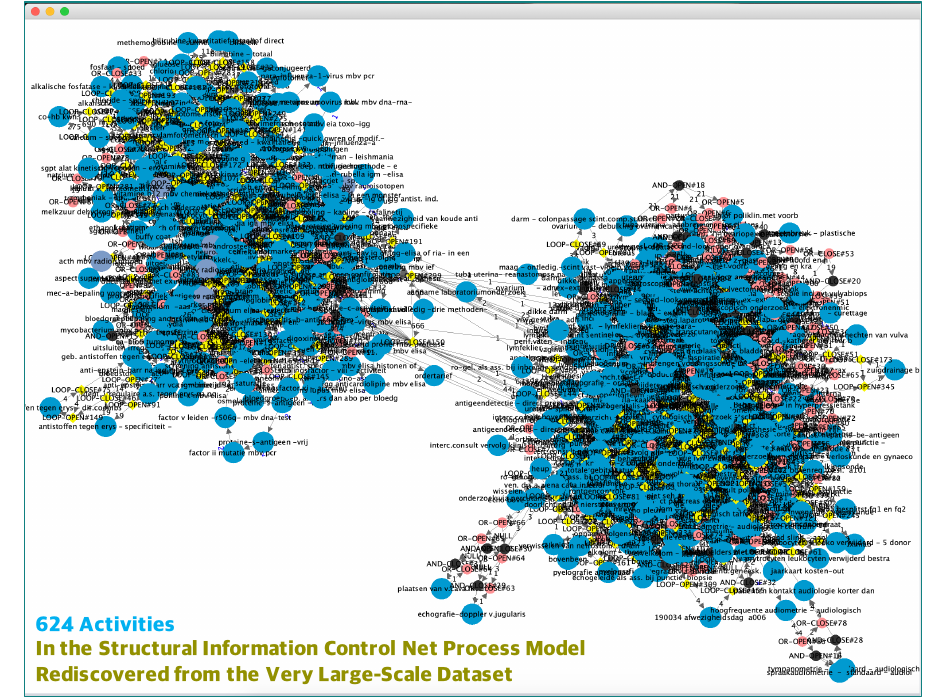
Figure 15. The rediscovered SICN process model with very large-scale and massively parallel business